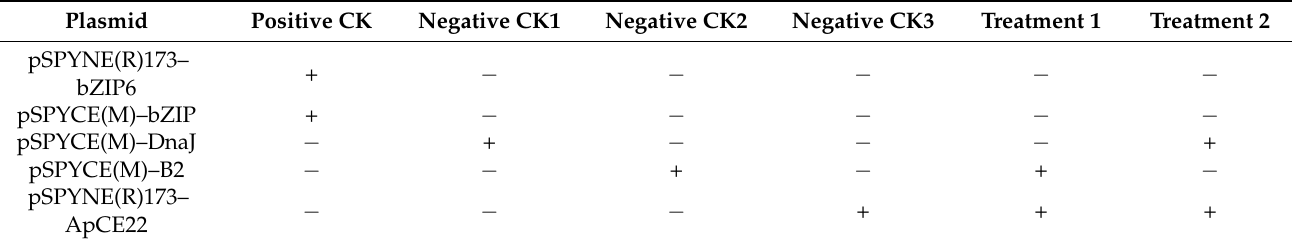
Table 1. BiFC’s experimental